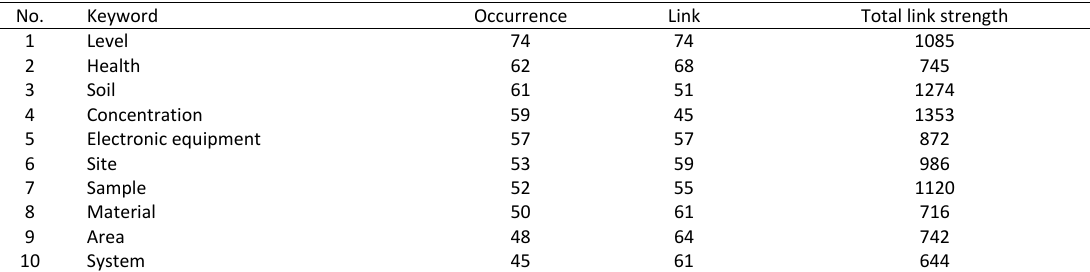
Table 4: Top 10 most occurring keywords